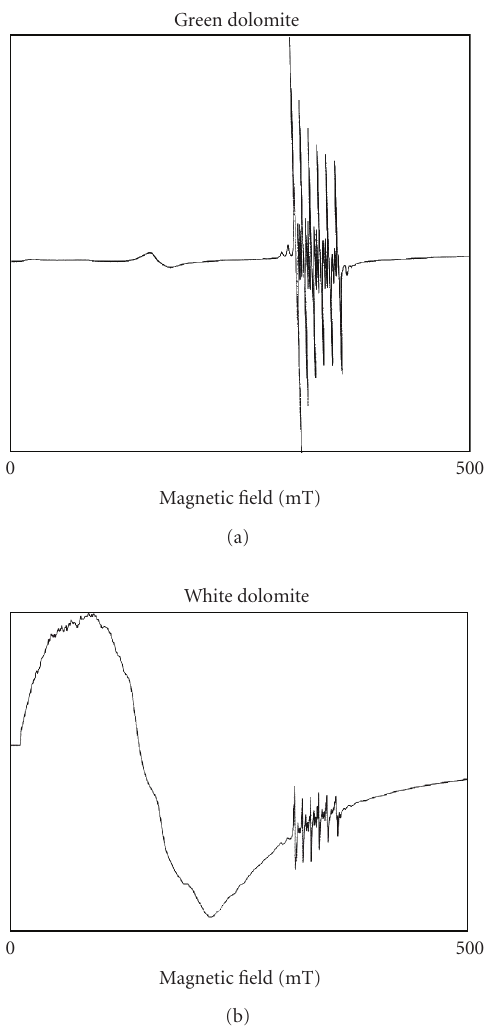
Figure 2: (a) Expanded form of EPR spectrum of green dolomite at RT ( v = 9 . 39128 GHz). (b) Expanded form of EPR spectrum of white dolomite at RT ( v = 9 . 39183